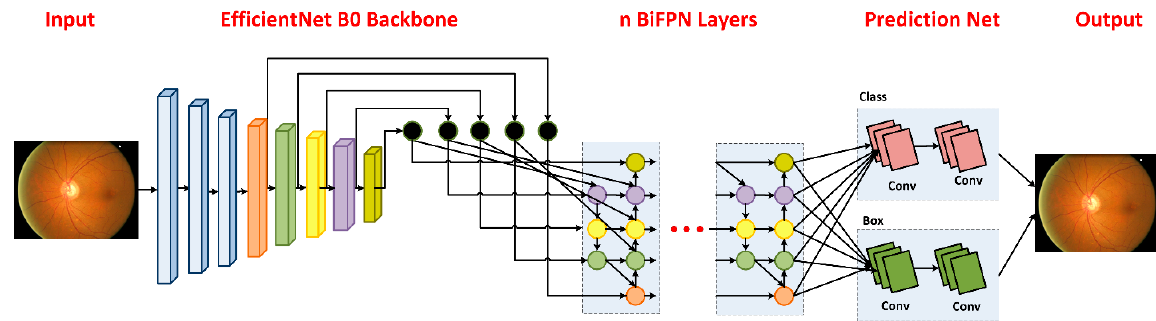
Figure 2. Flow diagram of Proposed Technique. Algorithm 1: Steps for the presented method.